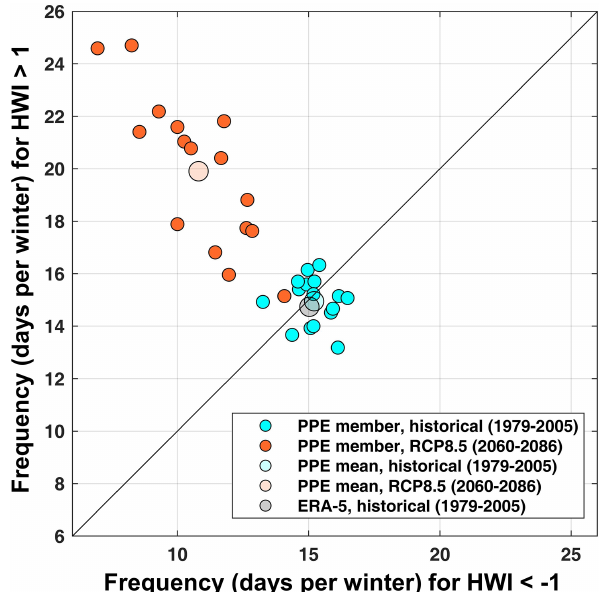
Figure 7. Frequency of haze-conducive weather (HWI > 1) versus frequency of clear weather (HWI < − 1) averaged over the histori- cal period (1979–2005) and the far-future (2060–2086) period un- der RCP8.5 using all PPE members. Small coloured circles denote individual PPE members whereas large coloured circles denote the means of the members. The grey circle shows the mean frequency from ERA-5 reanalysis for the historical period (1979–2005). The black solid line shows the 1 : 1 (identity)